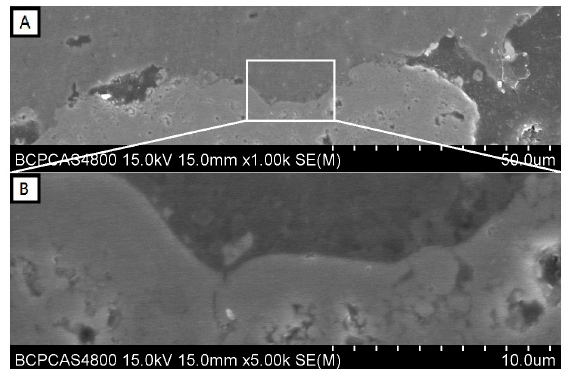
Figure 3. ( A ) Contact area of the CMAS-NiCr 2 O 4 boundary and ( B ) its high magnification image.